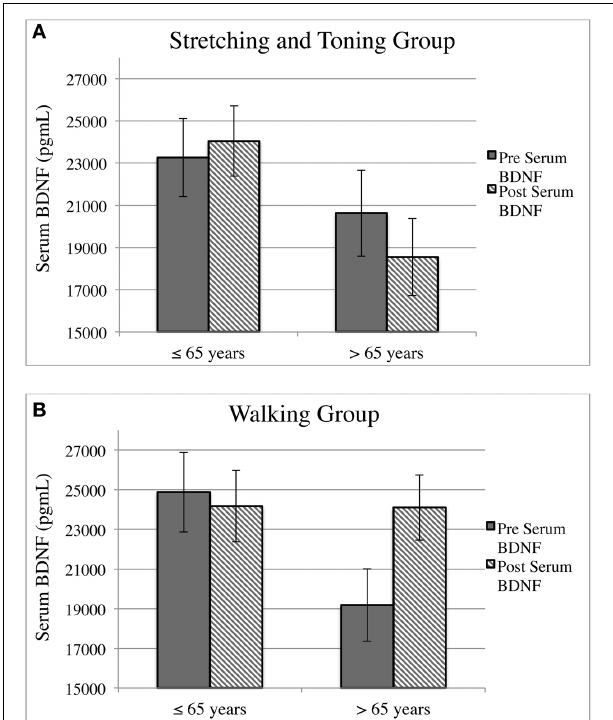
FIGURE 3 | Moderating effect of age (stratified). Note: Effects of exercise on serum BDNF as a function of age. Age stratified using a median split. (A) Serum BDNF decreases following the intervention in the control group among adults > 65 years. (B) Serum BDNF increases following 1 year of walking exercise, specifically for adults aged > 65 years.